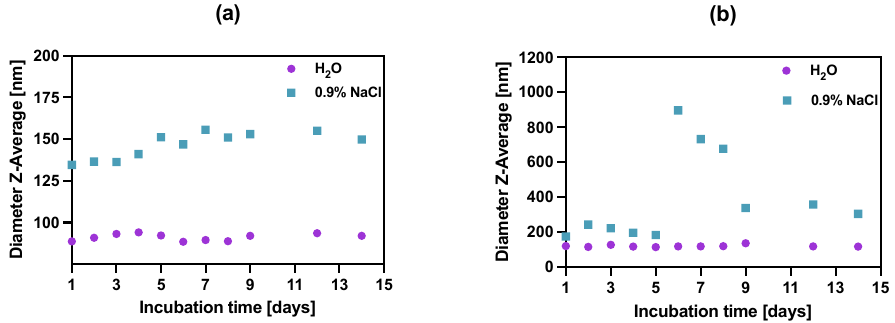
Figure 5. Stability studies of ( a ) NPs-PEG, ( b ) NPs-Tmab in water DI and 0.9% NaCl. Data are expressed as mean value ± SD ( n = 3). The error bars are the size of symbols used.